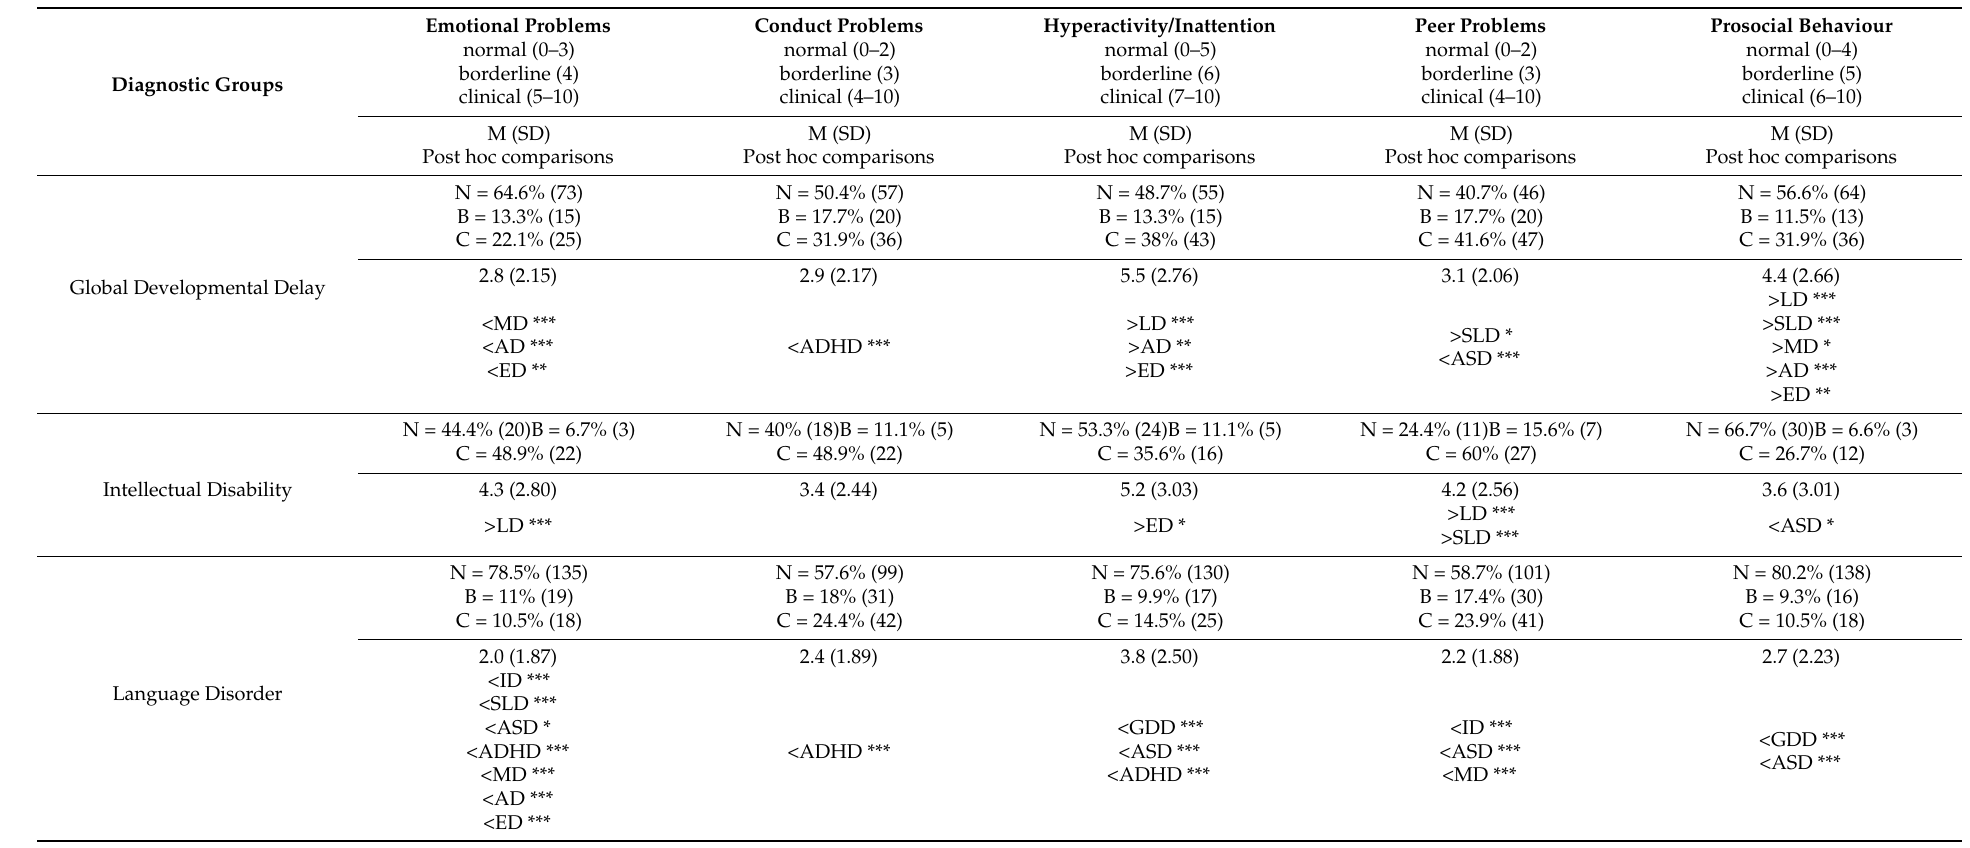
Table 1. Prevalence (%) and number of children and adolescents who showed normal, borderline, and clinical scores in the SDQ subscales for each diagnostic group, as well as the mean and standard deviation (SD) of the scores in the SDQ subscales and Post hoc